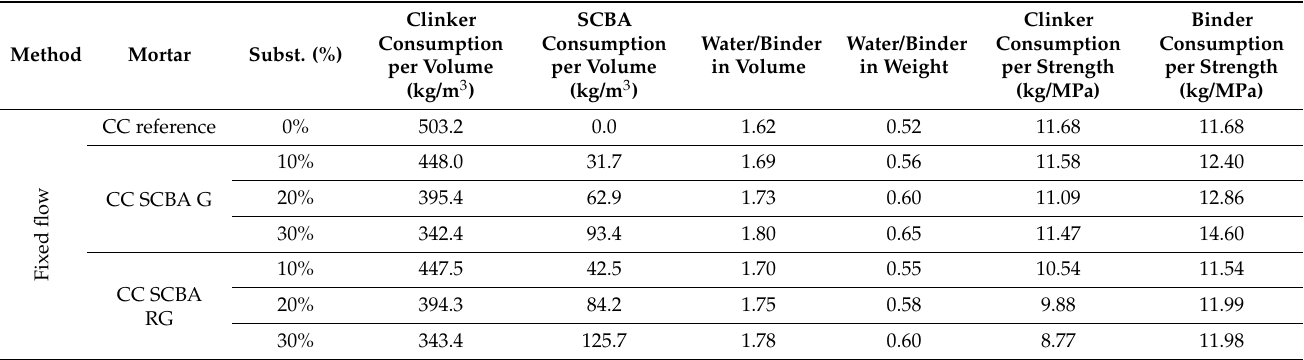
Table 7. Comparisons between cement or binder consumption due to the compressive strength of mortars with the fixed